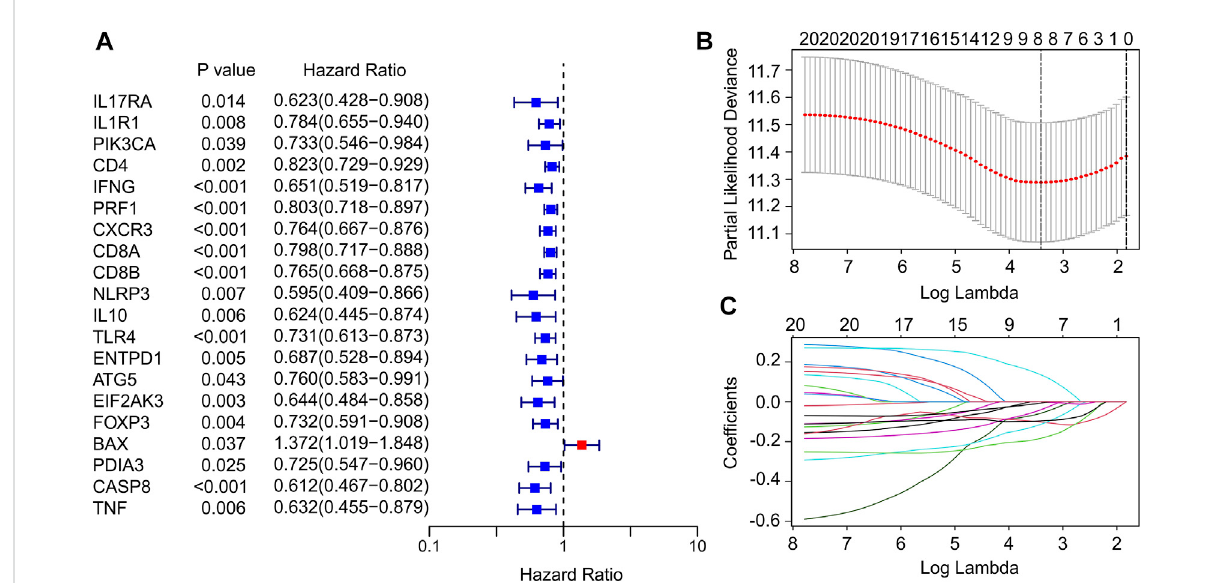
FIGURE 1 Identi fi cation of prognostic ICD-related genes in CM. (A) Univariate Cox regression analysis suggests that 20 ICD-related genes are associated withOSinCM. (B,C) Leastabsoluteshrinkageandselectionoperatoranalysis(LASSO)showstheminimallambdaandcoef fi cientsofprognosticICD- related